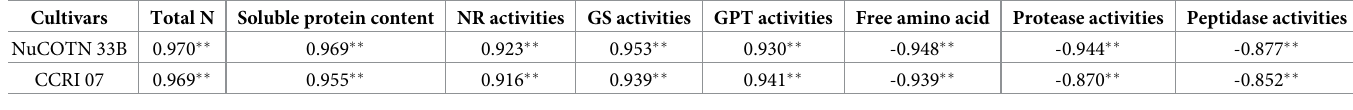
n = 21 �� and � represent significance at the 1% and 5% level, respectively.